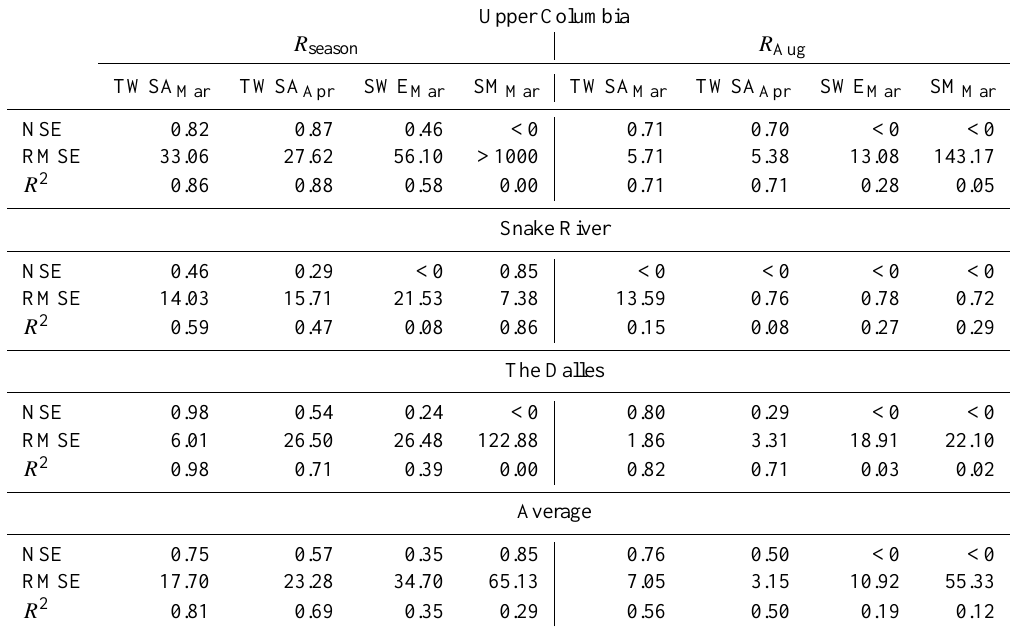
Table 1. Comparison of performance metrics using the dual-pass approach to apply GRACE TWSA data, model-derived snow (SWE), and soil moisture (SM) products in predicting seasonal ( R season ) and August ( R Aug ) runoff by watershed. Average values for the three basins are also provided. RMSE values are in mm. Complete results can be found in Appendix Table